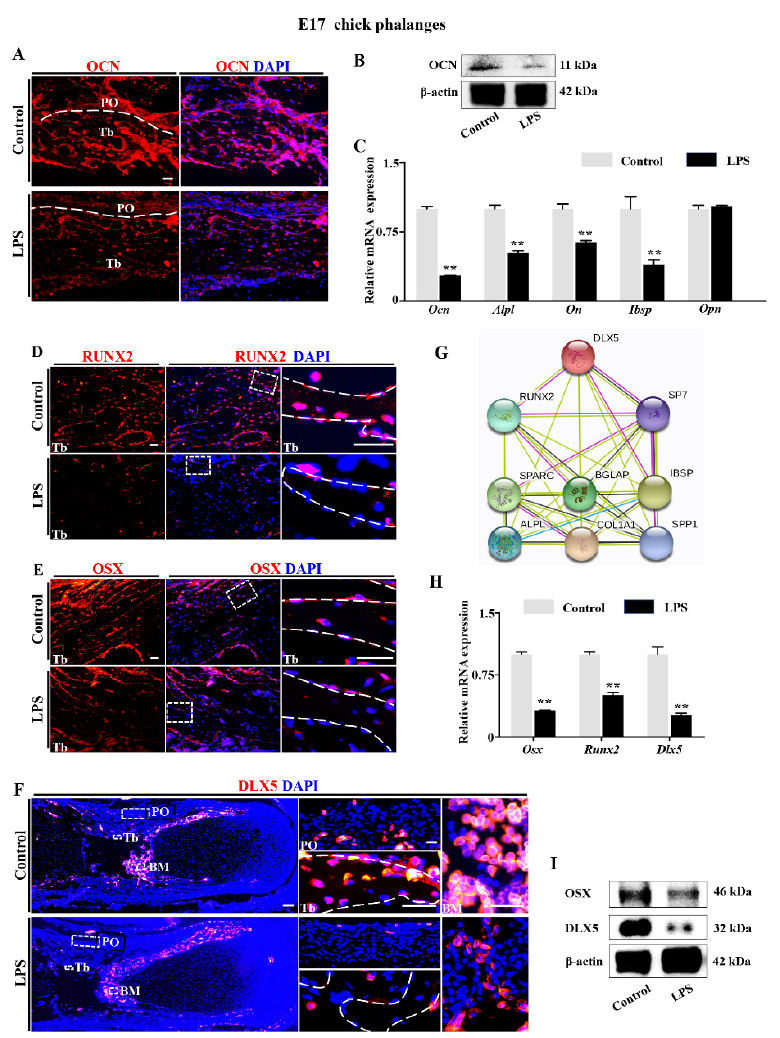
Figure 3. The assessment of the osteogenesis-related gene expressions following LPS exposure. ( A ) Representative images from immunofluorescent staining of OCN on the longitudinal sections of E17 chick phalange trabecular bone of control and LPS-treated groups, counterstained with DAPI. Dashed lines indicate the boundary between the periosteum (PO) and the trabecular bone (Tb). Negative controls were shown in Supplementary Materials (Figure S6). ( B , C ) Western blot ( B ) and qPCR ( C ) showing the expression of OCN ( B ), as well as the expressions of Alpl , On , Ibsp , and Opn at mRNA level of control and LPS-treated groups. ( D , E ) The representative immunofluorescent staining of RUNX2 ( D ) and OSX ( E ) on the longitudinal sections of E17 chick phalange trabecular bone of control and LPS-treated groups. The areas outlined by dotted squares in trabecular bone are shown at a higher magnification in the right panels. The edge of trabecular bone is delineated by a dashed line. Negative controls were shown in Supplementary Materials (Figure S6). ( F ) Representative immunofluorescent staining of DLX5 on the longitudinal sections of E17 chick phalanges of control and LPS-treated groups, counterstained with DAPI. Dotted squares in periosteum (PO), trabecular bone (Tb), and bone marrow (BM) are shown at higher magnification in right panels. The edge of trabecular bone is shown with a dashed line. Negative controls were shown in Supplementary Materials (Figure S6). ( G ) The protein–protein interactions from the STRING database showing the network of DLX5, RUNX2, OSX (Sp7), OCN (BGLAP), IBSP, osteonectin (SPP1), COL1 α 1 (COL1A1), ALPL, and osteopontin (OPN or SPARC). ( H ) qPCR data showing the expressions of Osx , Runx2 , and Dlx5 of control and LPS-treated groups. ( I ) Western blot data showing the expressions of DLX5 and OSX of control and LPS-treated groups. Scale bars = 50 µ m in ( A , D , E , F ). (** p < 0.01)